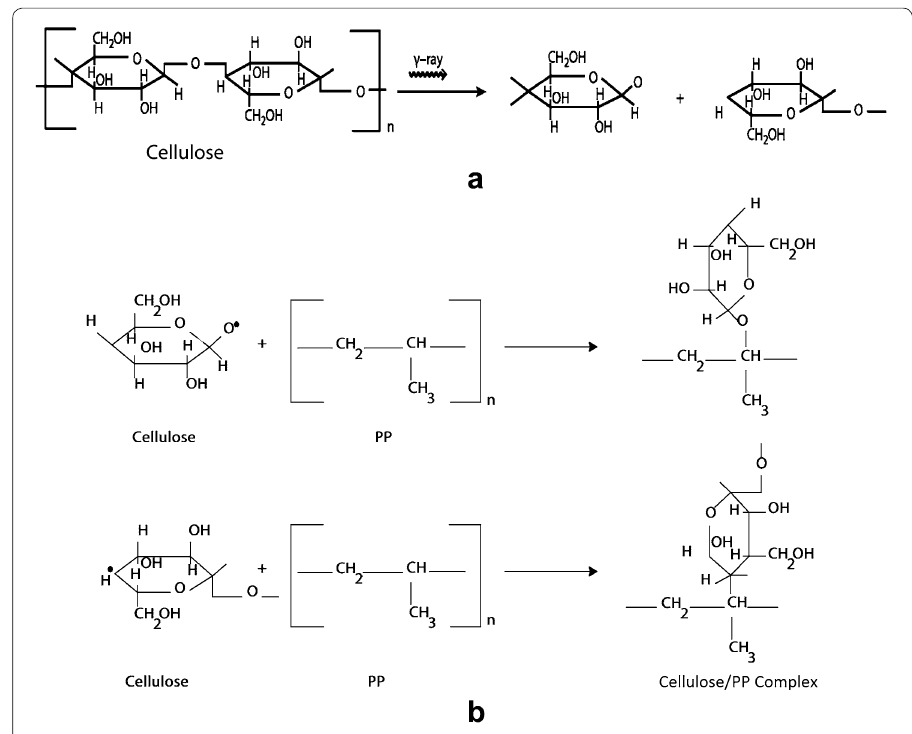
Fig. 7 a Chain scission mechanism of cellulose during gamma irradiation. b A possible cross-linking mechanism between cellulose and PP molecules